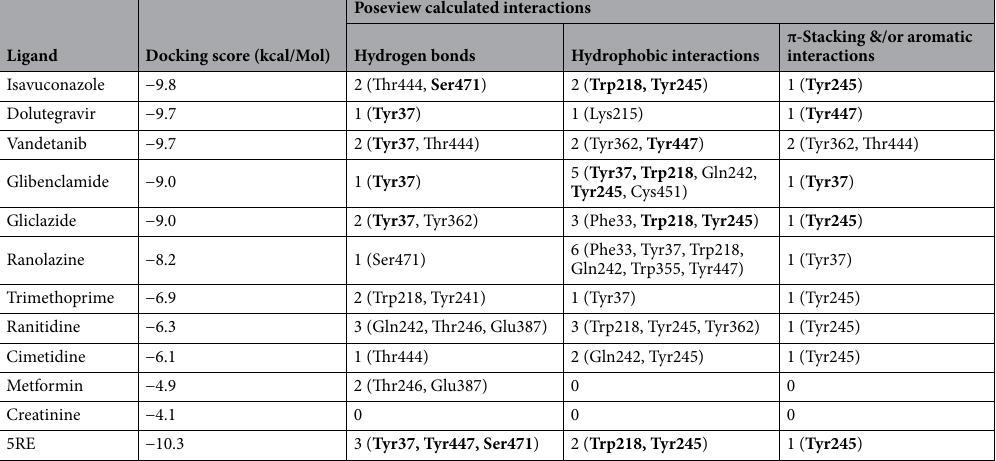
Table 6. Docking scores and number of interactions predicted for 11 drugs and 5RE inhibitor docked to the active site of the SLC22A2 haplotype 1 (WT). Interactions calculated using Poseview. Number in front of brackets is the total number of interactions observed. Three letter aa code: Thr threonine, Trp tryptophan, Tyr tyrosine, Lys lysine, Gln glutamine, Cys cysteine, Phe phenylalanine, Glu glutamine, Ser serine. The residue highlighted in bold shows similar interacting residue shared between the top binders: i.e. 5RE, Isavuconazole, Dolutegravir, Vandetanib, Glibenclamide and Gliclazide.